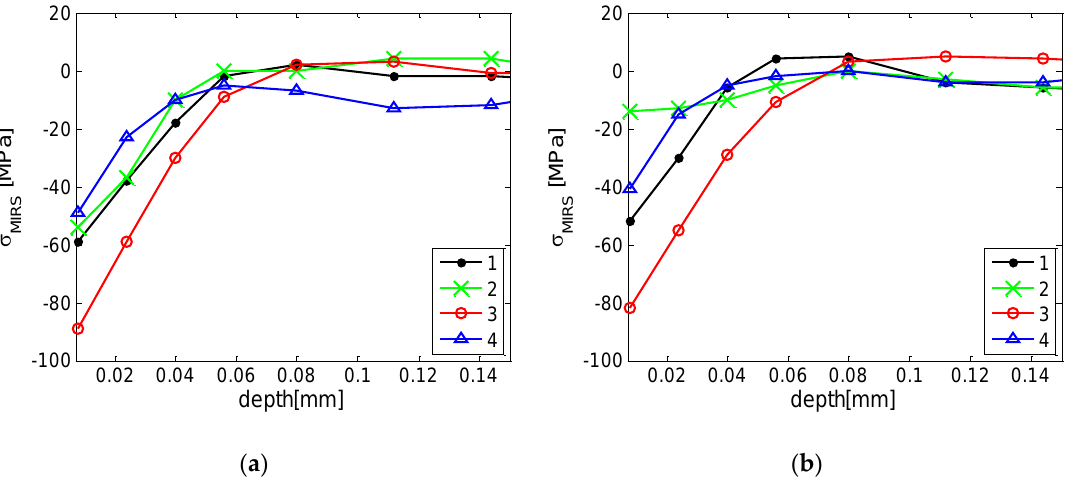
Figure 7. Variability of MIRS profiles measured by incremental hole drilling in four different locations: Distribution of longitudinal stresses vs. depth ( a ) and distribution of transverse stresses vs. depth ( b ).